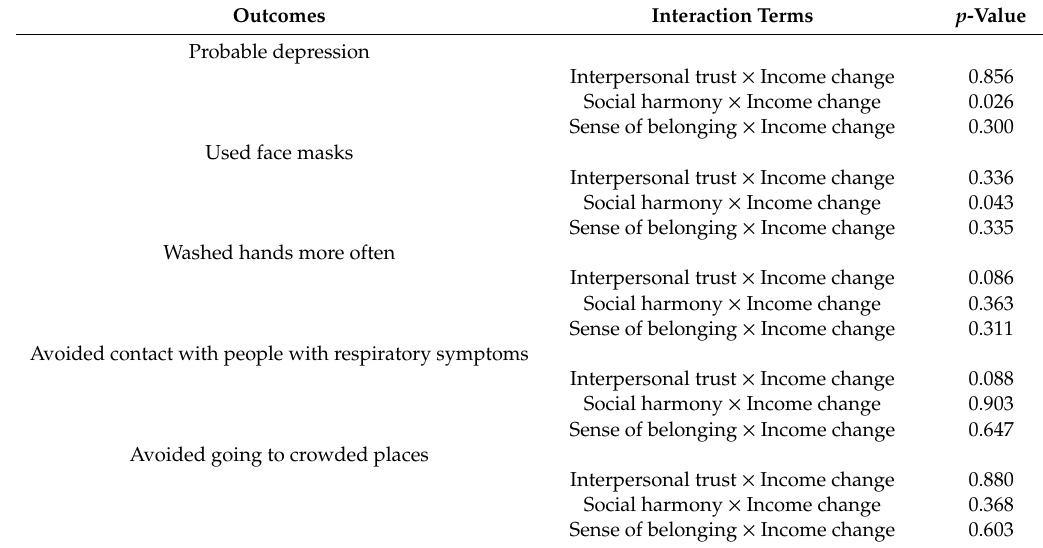
Table A1. Interaction e ff ects of social capital and income change on probable depression and adoption of preventive